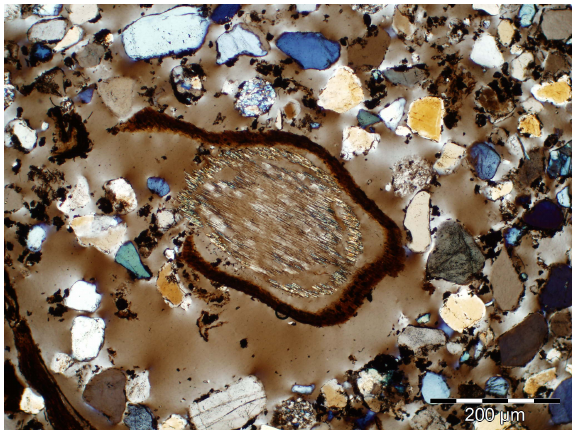
Figure 3. Cross-section of a (living) tree root in the thin section of the 2 Aan of Nabbegat (70–80cm). Characteristic is the double fringing of the root tissue. Such roots were only found in the upper part of the 2Aan of Nabbegat. Roots of crop species were not found in the thin sections of the three profiles; they decompose rather fast compared with tree